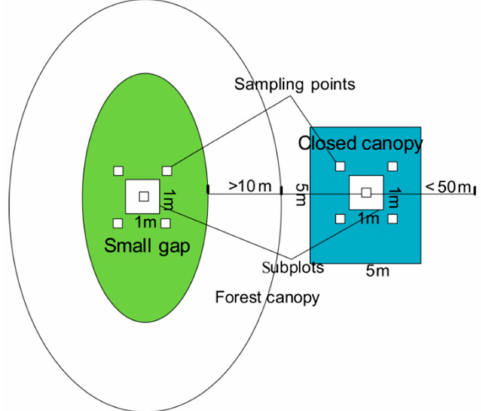
Figure 2. Experimental design of sample plots and sampling points between small gap and closed canopy.